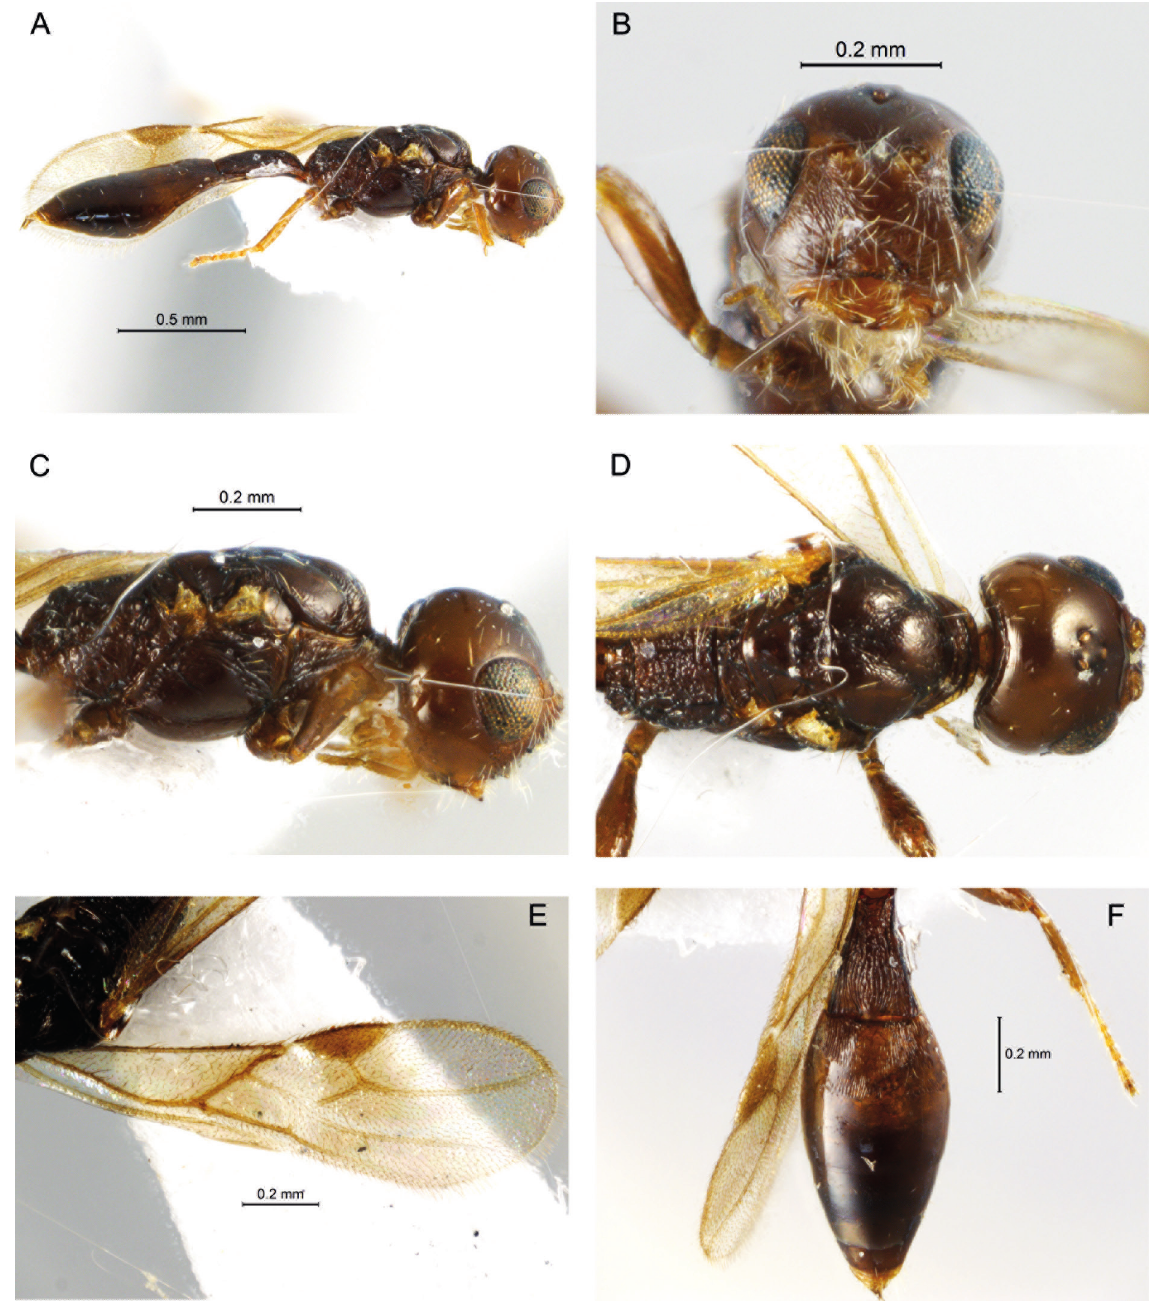
Fig. 4. Hecabolus gavinbroadi sp. nov., ♂, paratype (CNIN-IBUNAM). A . Habitus, lateral view. B . Head, frontal view. C . Mesosoma, lateral view. D . Mesosoma, dorsal view. E . Fore wing, showing the moderately wide pterostigma. F . Metasoma, dorsal